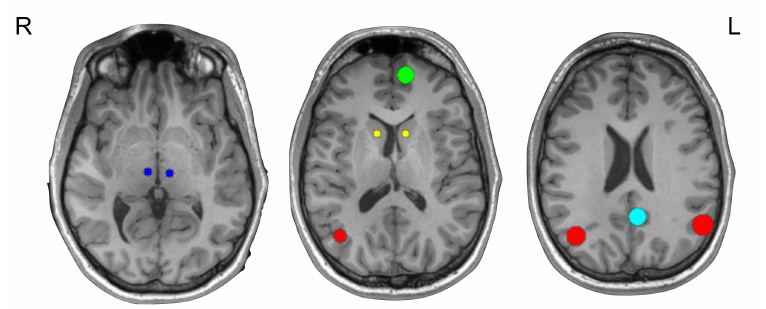
Figure 1. Regions of interest for DCM analyses, on the T1 of a representative healthy control and. Red, IPL; green, MPFC; light blue, PCC; dark blue, thalamus; yellow, striatum; L, left hemisphere; R, right hemisphere; HC, healthy